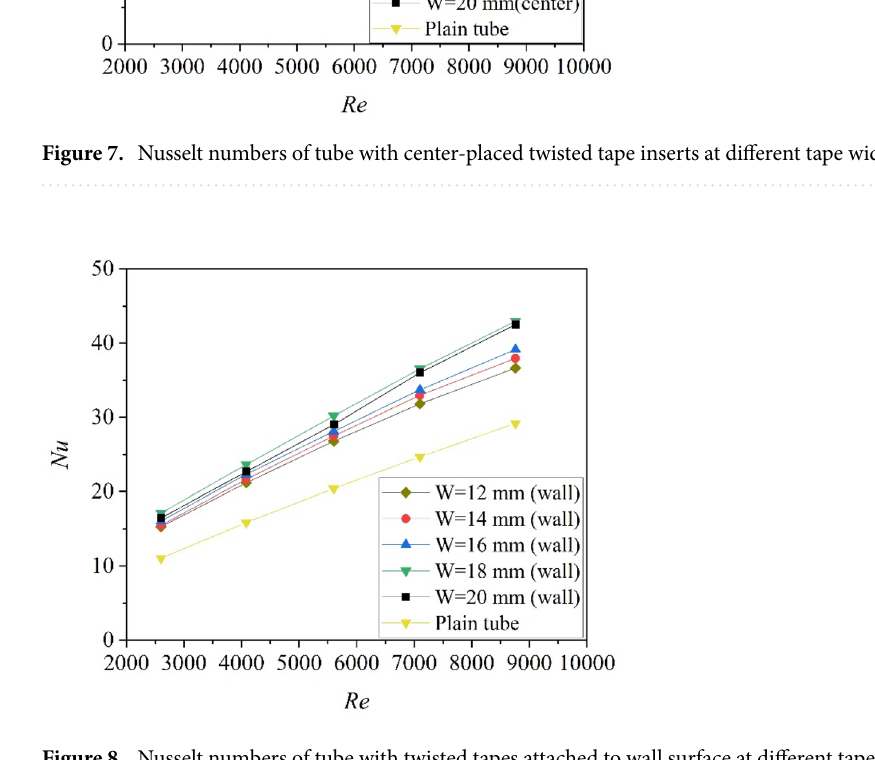
Figure 8. Nusselt numbers of tube with twisted tapes attached to wall surface at different tape